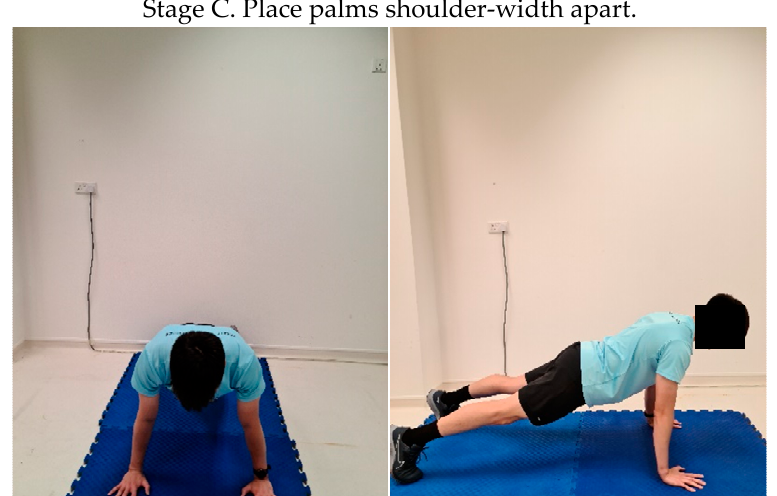
Stage C. Place palms shoulder-width apart.